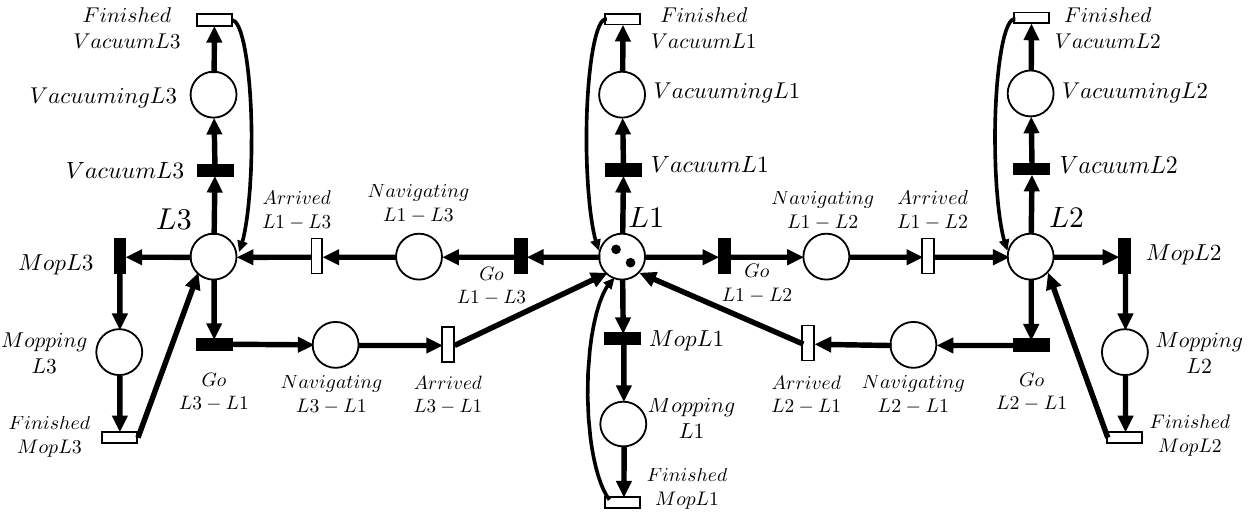
Figure 4. GSPNR obtained from the composition of the models in Figure 3 and the topological map in Figure 1